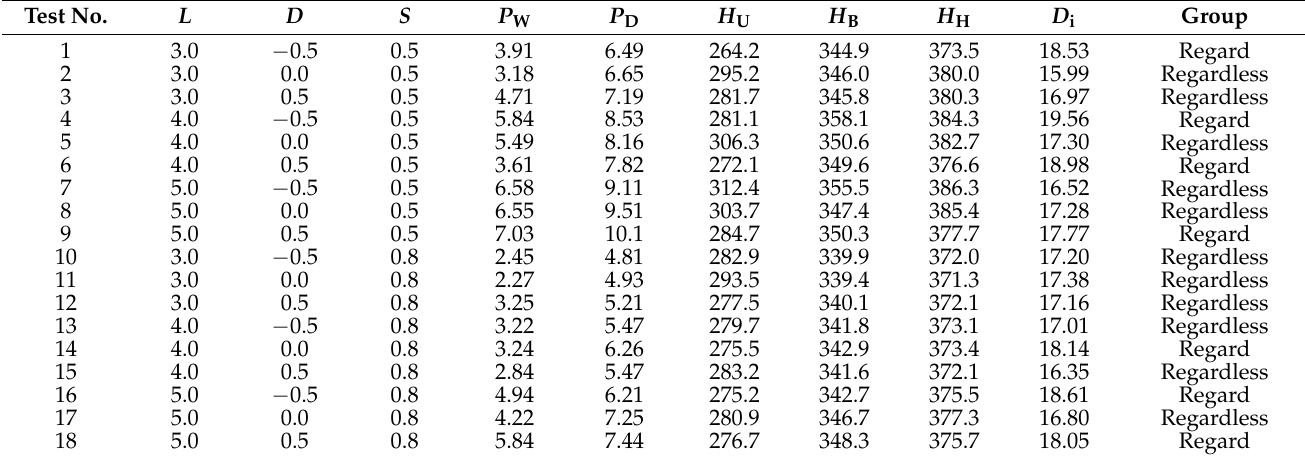
Table 9. Learning data for discriminants of fiber laser welding